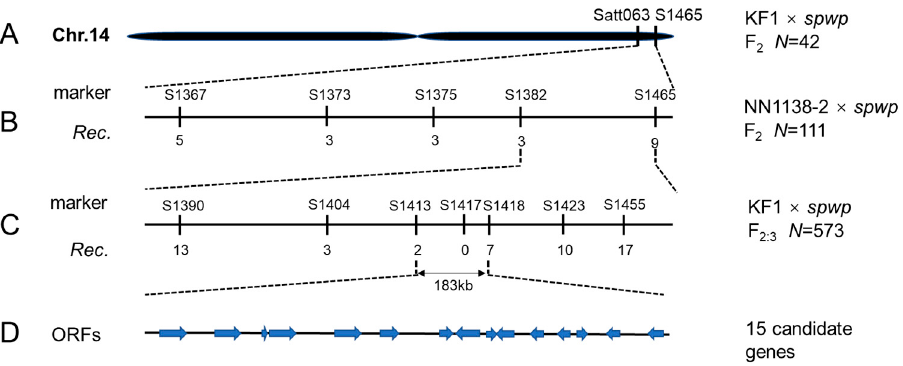
Figure 3. Fine-mapping of the spwp1 locus. ( A ): the spwp1 locus was initially mapped by single- sequence repeat (SSR) markers Satt063 and S1465 on chromosome (Chr.) 14 using 42 mutant plants derived from the F 2 population of KF1 × spwp . ( B ): the spwp1 locus was further mapped to a region between SSR markers S1382 and S1465 using theF 2 population of NN1138-2 × spwp . ( C ): the position of the spwp1 locus was finally narrowed down to a genomic region of 183 kb between SSR markers S1413 and S1418 using the F 2:3 population of KF1 × spwp . ( D ): Fifteen predicted open reading frames (ORFs) were located in this region according to the Williams 82 reference genome ( Glycine max